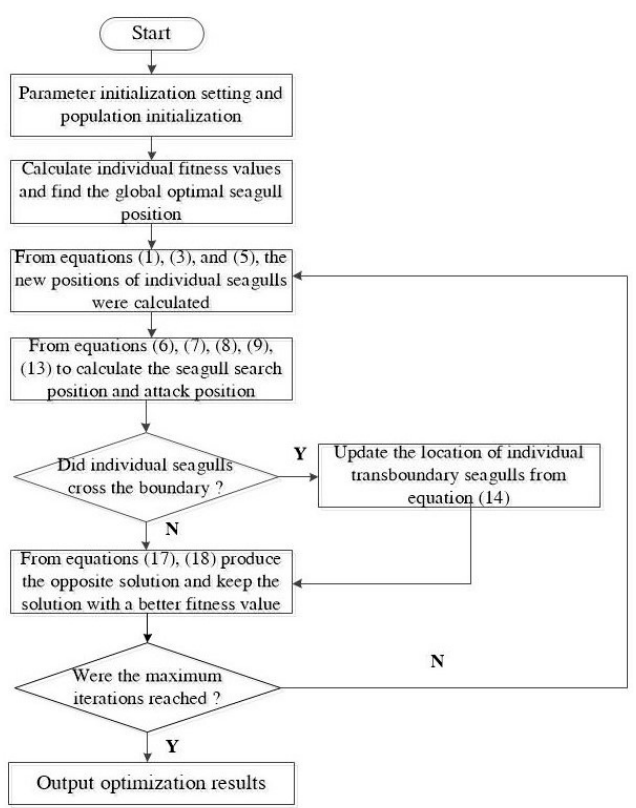
Figure 2. A schematic diagram of the GEN − SOA